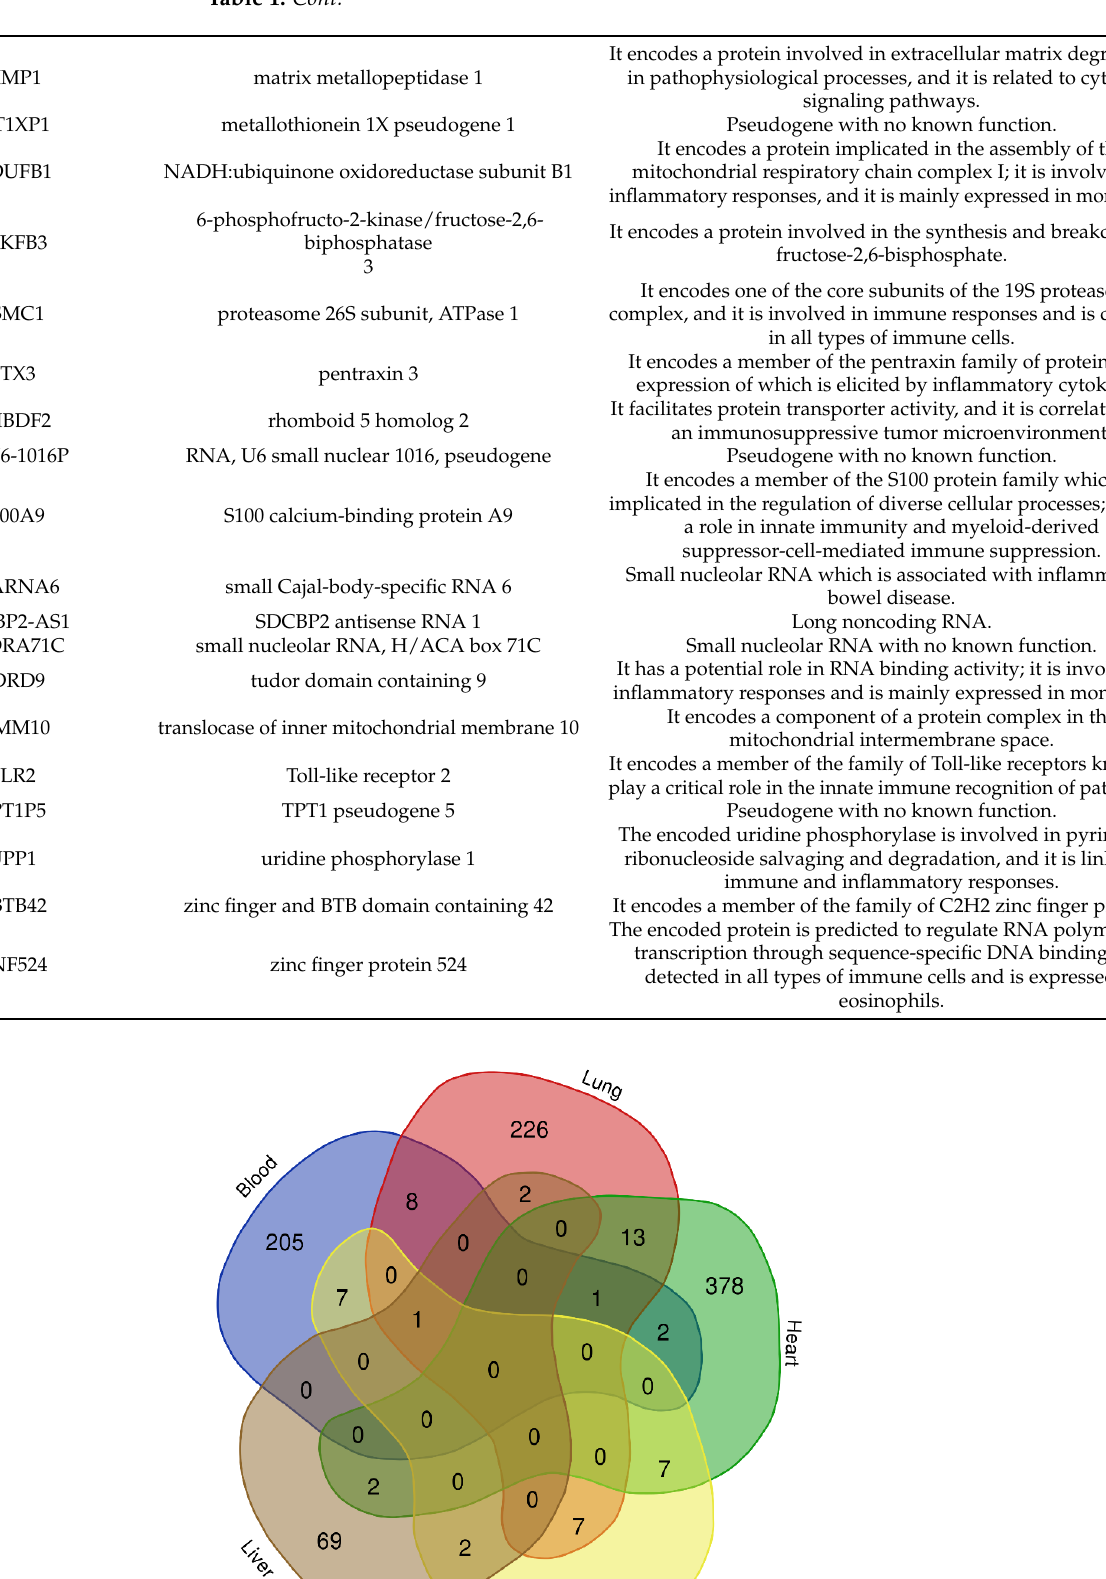
Figure 3. Venn diagram of the overlapping DEGs among tissues.